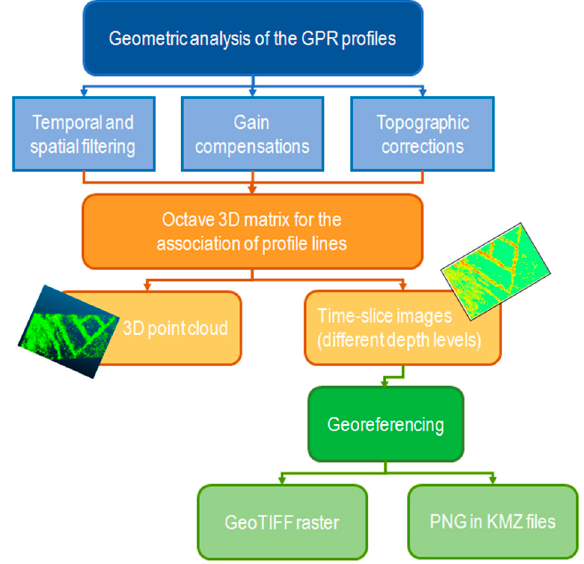
Figure 2. Workflow of the “toGPRi” tool developed for GPR data processing.